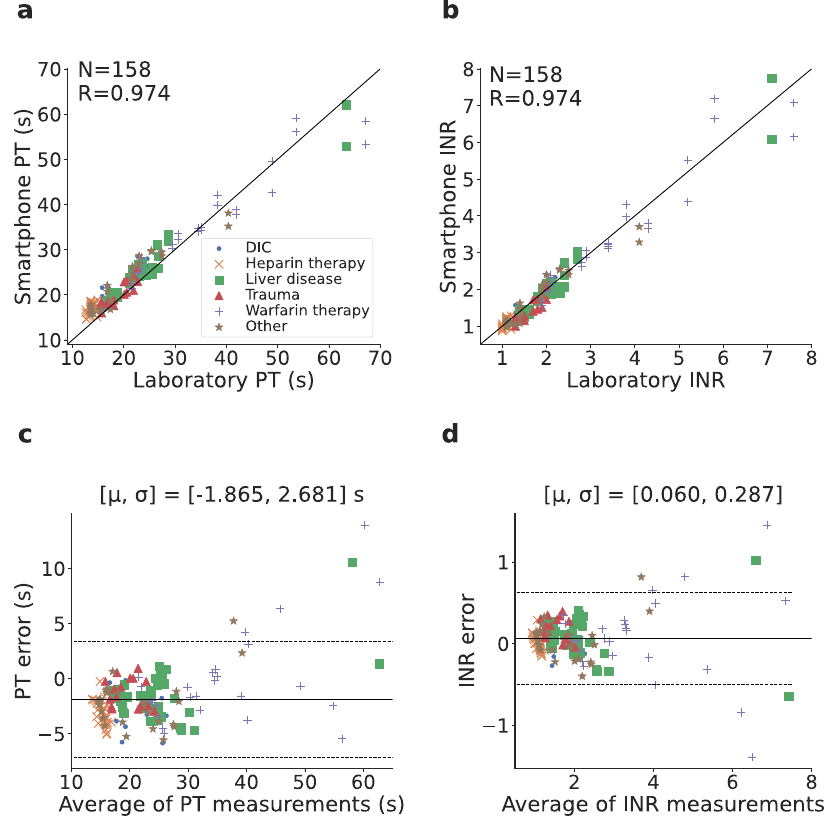
Fig. 4 Coagulopathy testing results. a – d Correlation and Bland-Altman plots comparing coagulopathic plasma PT/INR values from the smartphone system and the clinical-grade coagulation analyzer. In the Bland-Altman plot, μ is the mean error and σ is the standard deviation (SD) of the errors, the solid line represents the mean error and the dotted lines represent the 95% limits of agreement. Source data are provided as a Source Data fi